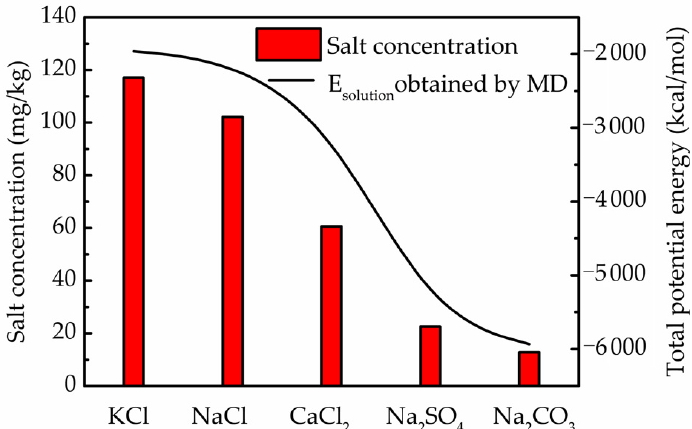
Figure 7. Relationship between total potential energy and equilibrium concentration in different inorganic salt systems.